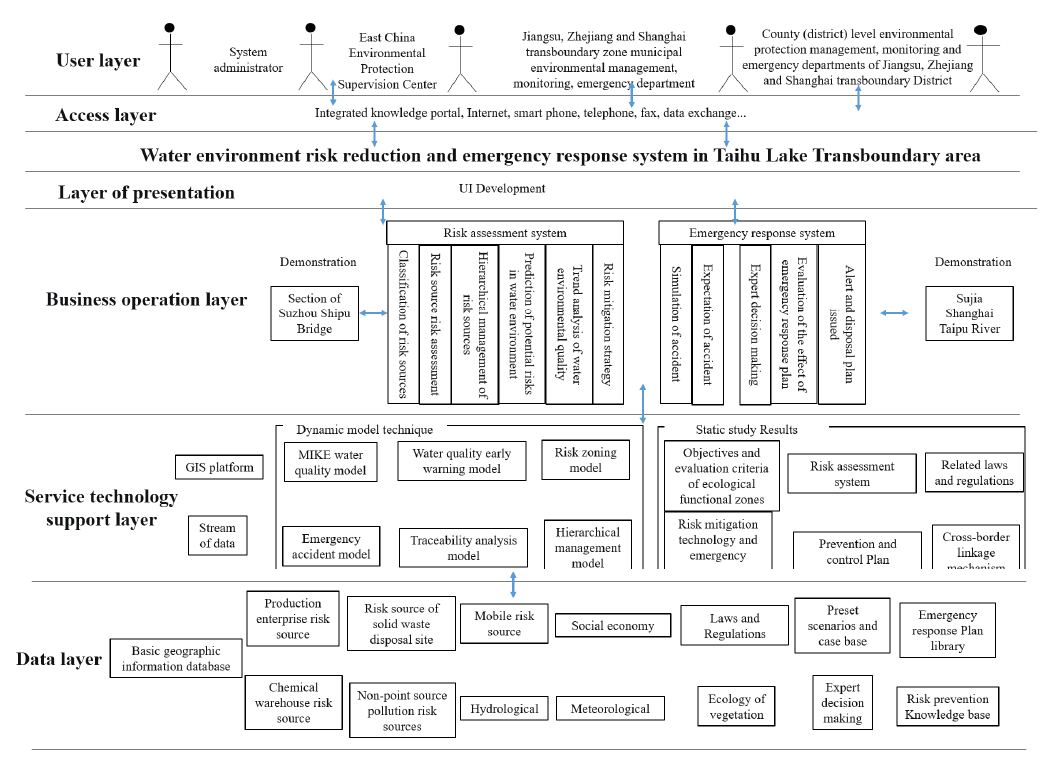
Figure 1. Diagram of the system framework.